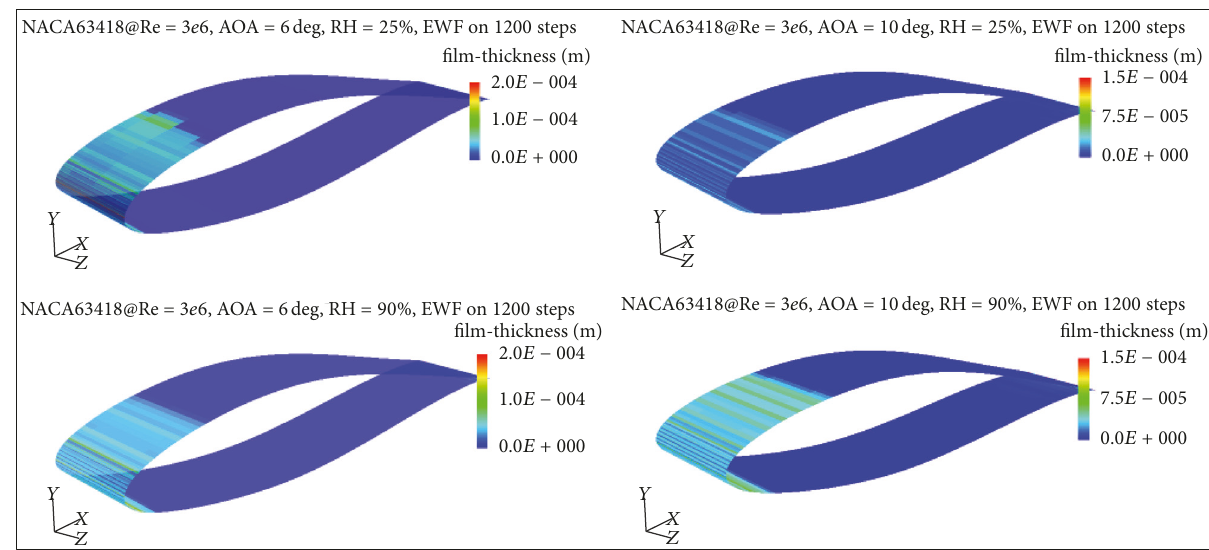
Figure 11: Contour plots of water film thickness on airfoil for AOA = 6, 10 degrees (EWF